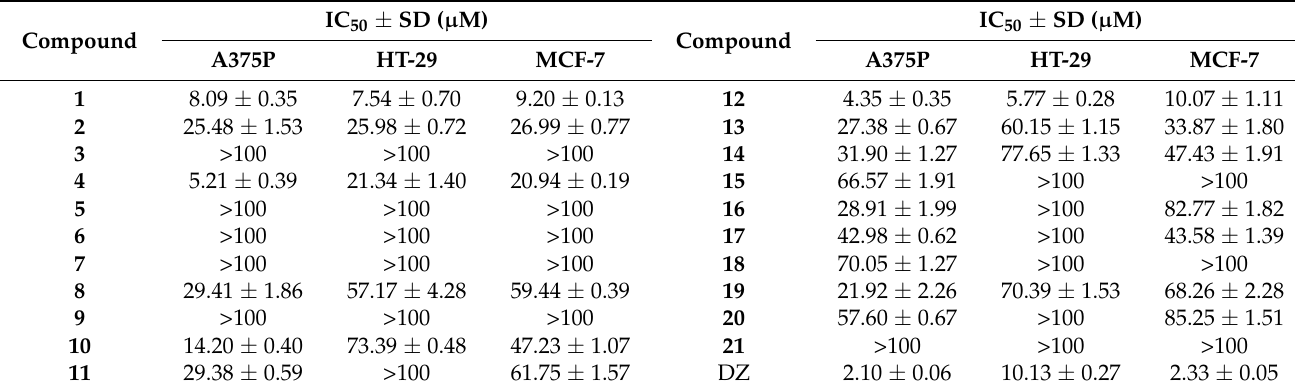
Table 4. Cytotoxic activities of compounds 1 – 4 and their metabolites 5 – 21 a